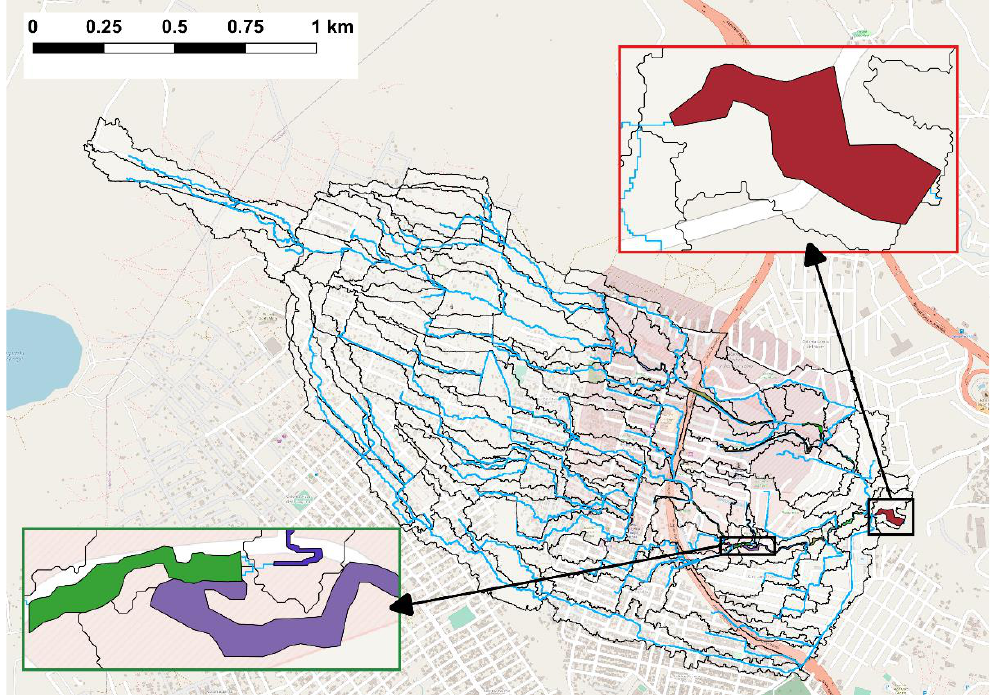
Figure 10. Inundation map along the two main branches of 100-year design storm in May.